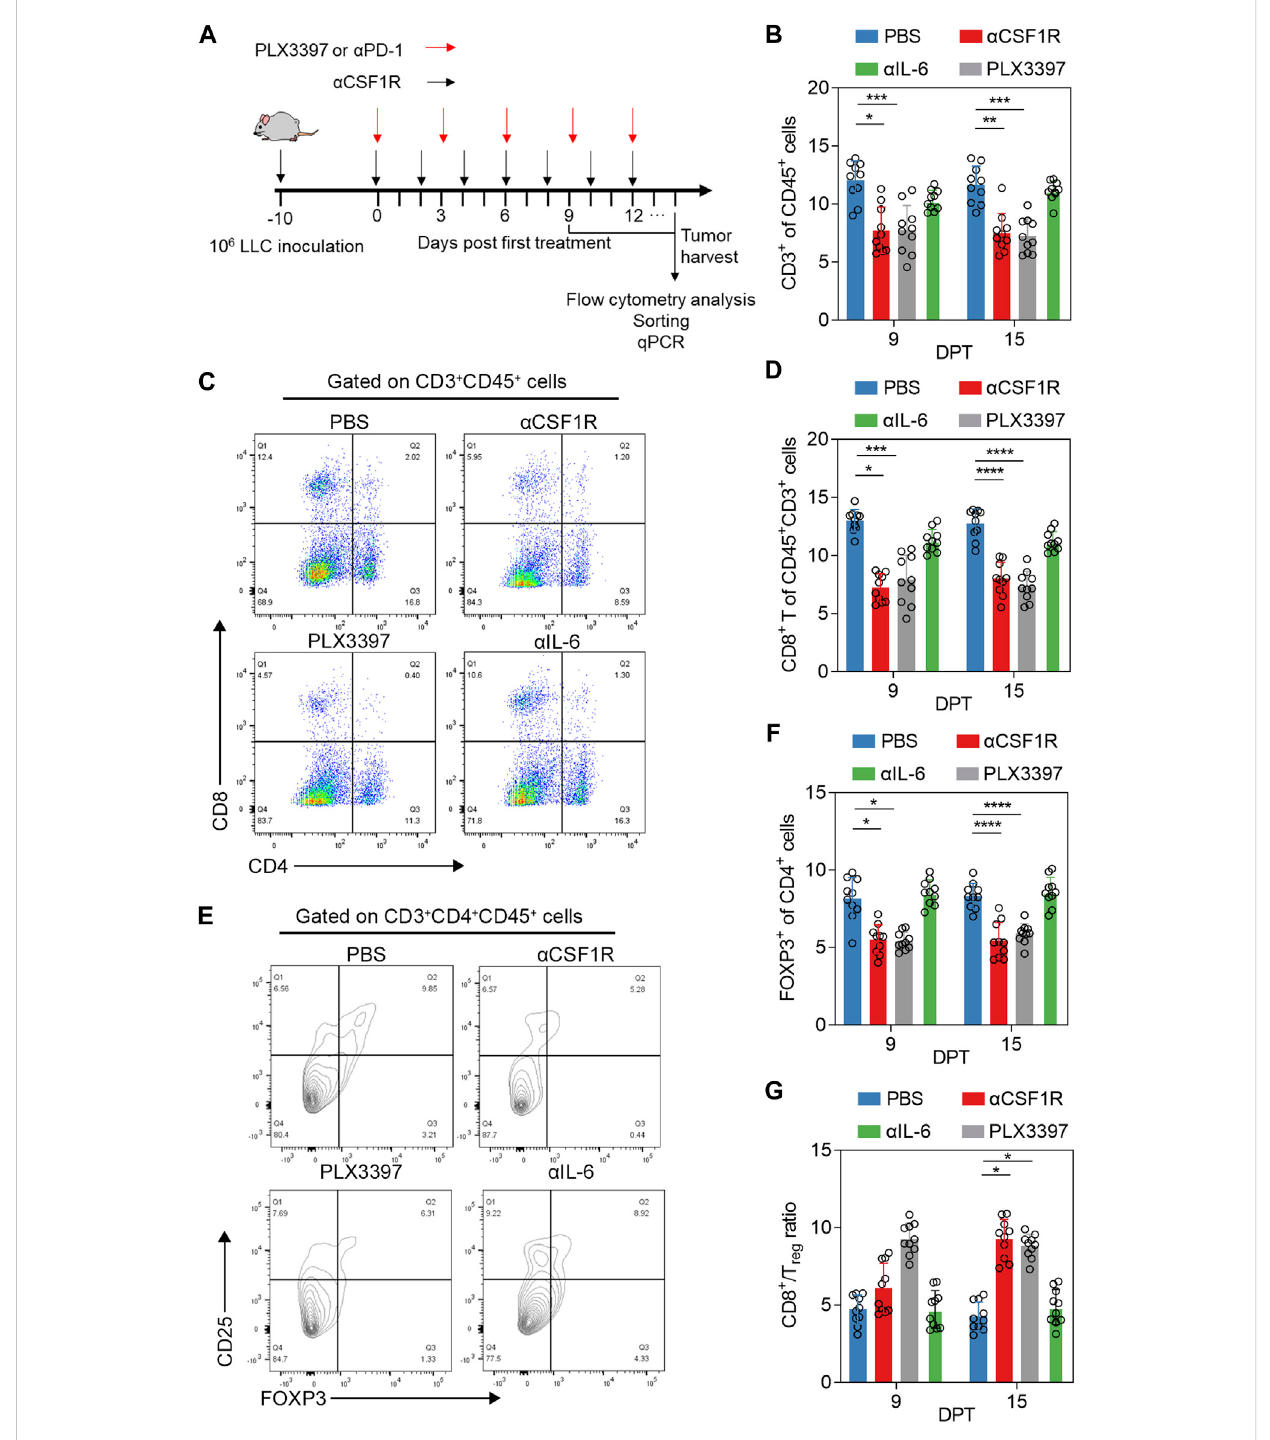
FIGURE 2 Phenotype and proportion of T cells in tumor after α CSF1R or PLX3397 treatment. (A) A graphical representation showed the time line of in vivo experiment, 10 6 LLC cells was inoculated to the right fl ank of mice, about 10 days post inoculation, the tumor volume would reach about 300 mm 3 and drug administration begin, the fi rst day of drug administration was recorded as Day 0 post treatment, paratumoral injection was performed as representation described until reached humane endpoint. (B) The proportion of CD3 + cells intumor-in fi ltrating immunecells changedon nineDPT and 15 DPT, the gate strategy was shown in Supplementary Figure S1; (C) Representative fl ow cytometry dot plot about CD8 + T of CD3 + CD45 + cells on nineDPT; (D) statistical resultsaboutCD8 + TofCD3 + CD45 + cellson day9and15aftertreatment; (E) Representative fl owcytometry contourblotofTreg cells on day 9 after treatment and (F) proportion of Treg cells on 9 and 15 DPT; (G) The ratio of CD8 + T cells/Treg cells on 9 and 15